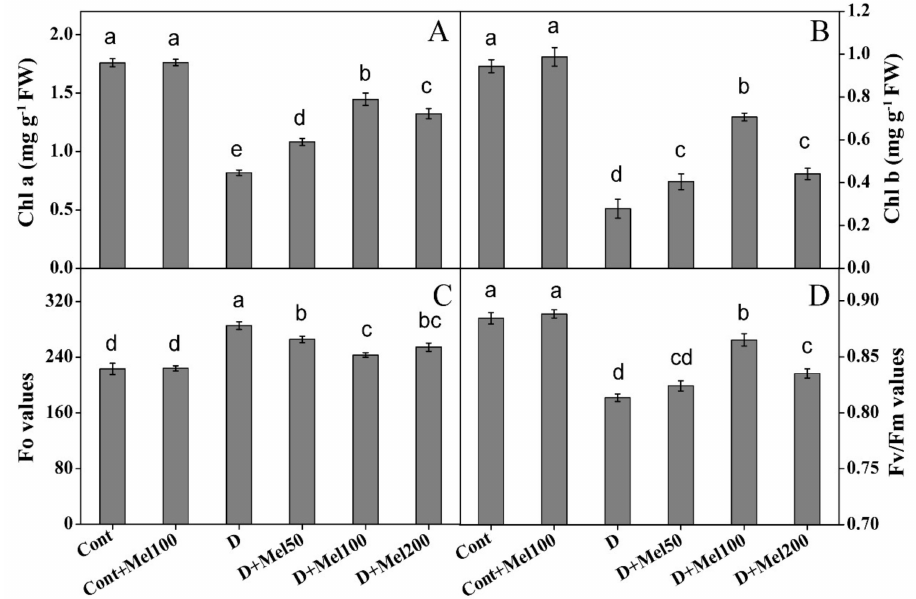
Figure 2. The e ff ect of melatonin on ( A ) chlorophyll a, ( B ) chlorophyll b, ( C ) FO values, ( D ) Fv / Fm values in Tartary buckwheat under drought stress. Here, Cont: Control, 80% field capacity (FC); D: Drought, 20% FC; Mel50: 50 µ M melatonin; Mel100: 100 µ M melatonin, Mel200: 200 µ M melatonin, Chl a: chlorophyll a, and Chl b: chlorophyll b. Values of all data are represented as mean ± standard error with three replications. Means values indicated with di ff erent letter refer to statistically significant di ff erences at p ≤ 0.05, according to Duncan’s multiple range